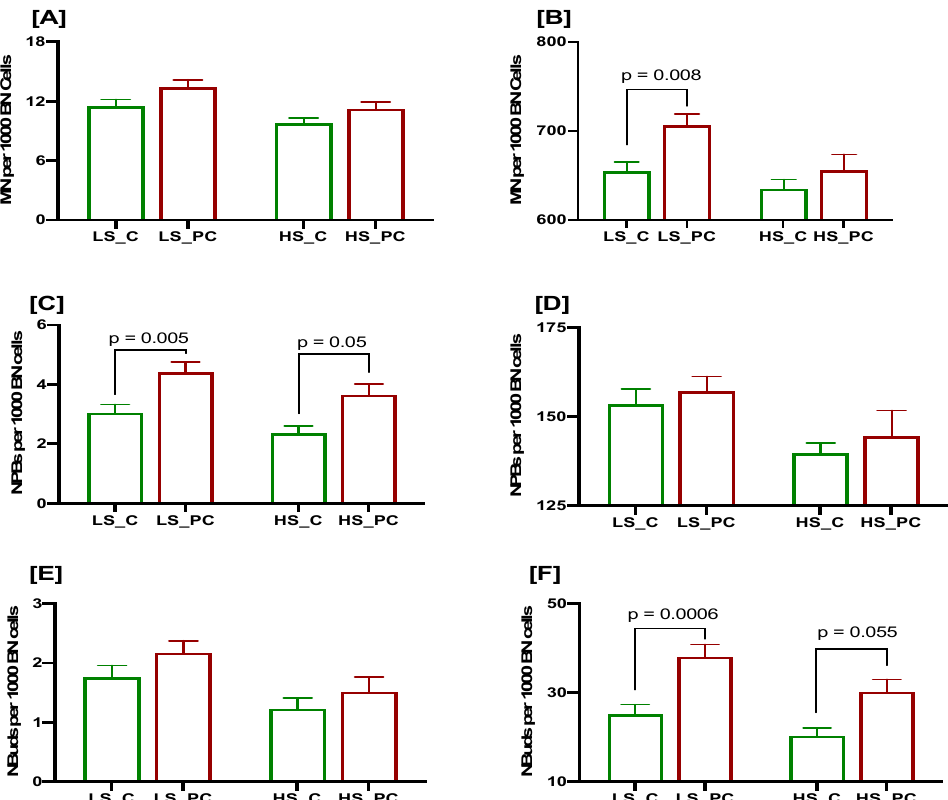
Figure 2. CBMN Cytome assay biomarkers in PC patients (red bars) and age-matched healthy controls (green bars) stratified as per selenium concentration (LS: low selenium; HS: High selenium); MN frequency at baseline ( A ) and after 3 Gy irradiation ( B ); NPBs at base line ( C ) and after 3 Gy irradiation ( D ); NBuds at baseline ( E ) and after 3 Gy irradiation ( F ). N = 63, 69, 69 and 34, respectively, from left to right for each bar. p values are only indicated for those comparisons that are significant.